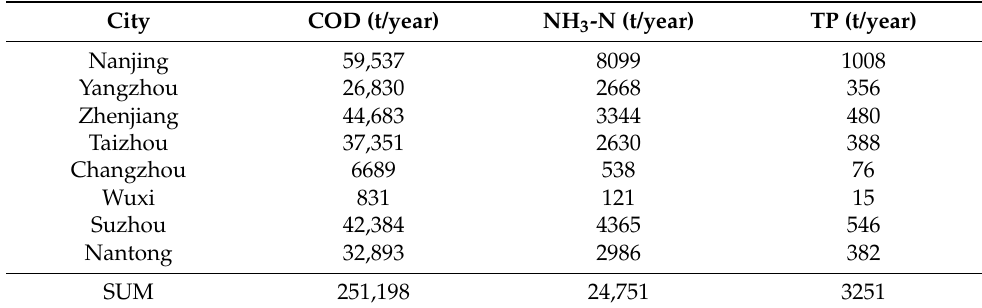
Table 4. Water environmental capacity (WEC) of eight cities.